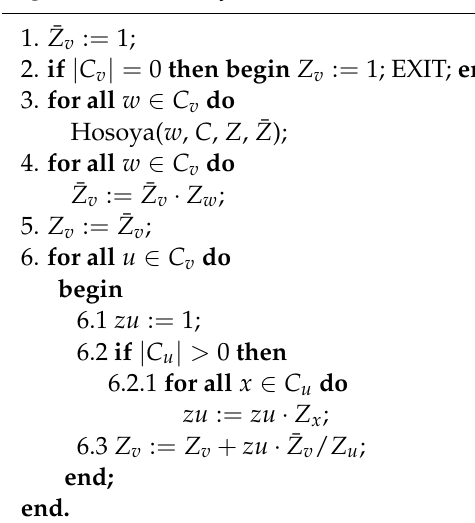
Algorithm 2. Hosoya( v , C , Z , ¯ Z